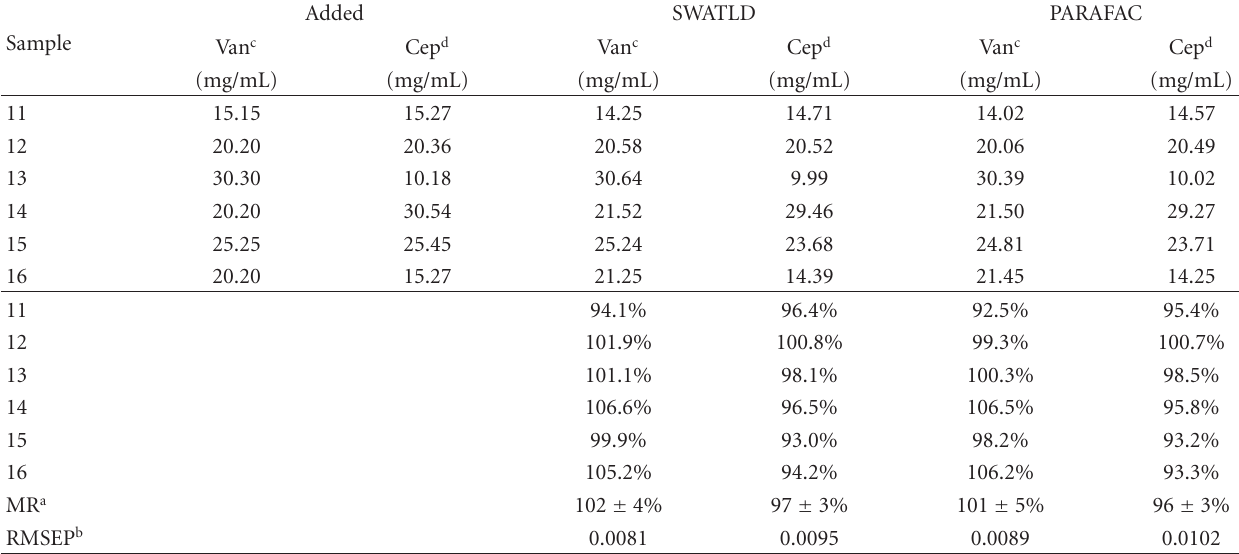
Table 1: Determination results of vancomycin and Cephalexin by HPLC-DAD using PARAFAC-ALS and SWATLD algorithm in human plasma ( N =